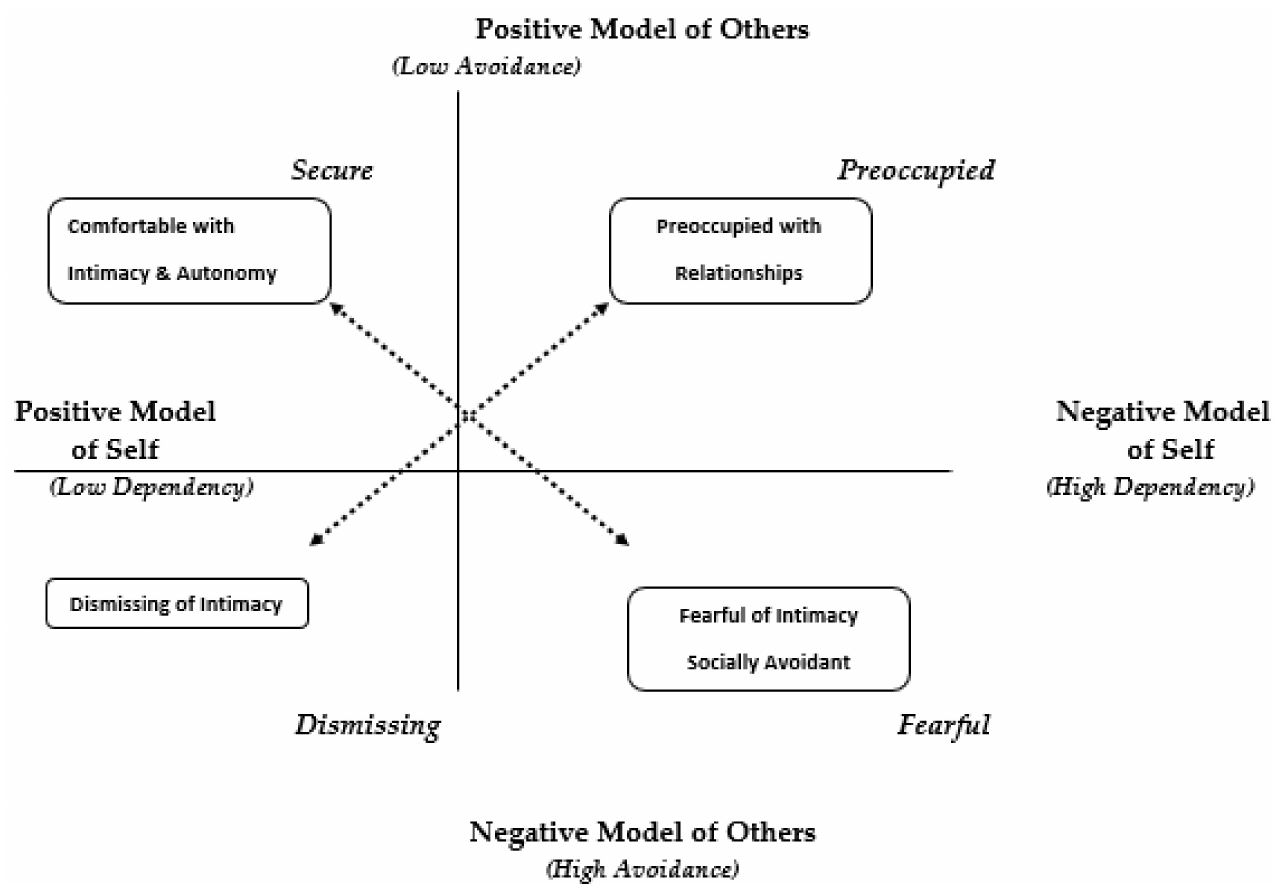
Figure 1. Bartholomew’s (1990) Four-Factor Model of Adult